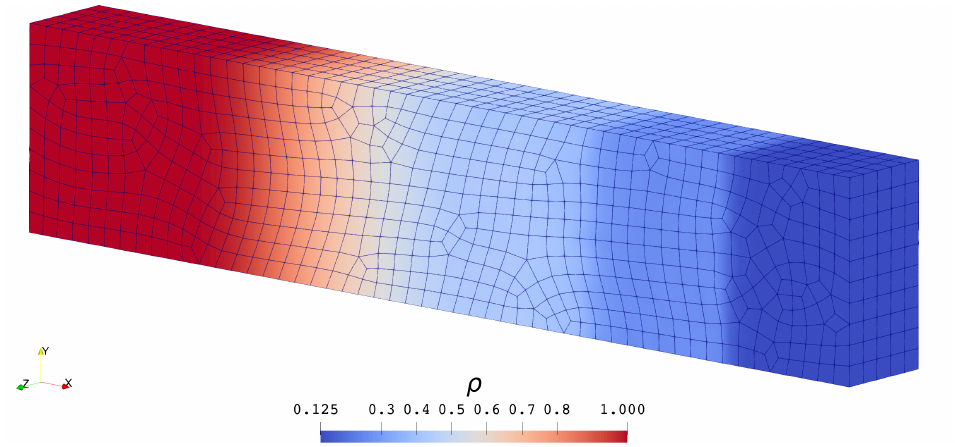
Figure 13. Third-order solution of ρ ( t = 1.0 ) in Problem 3.